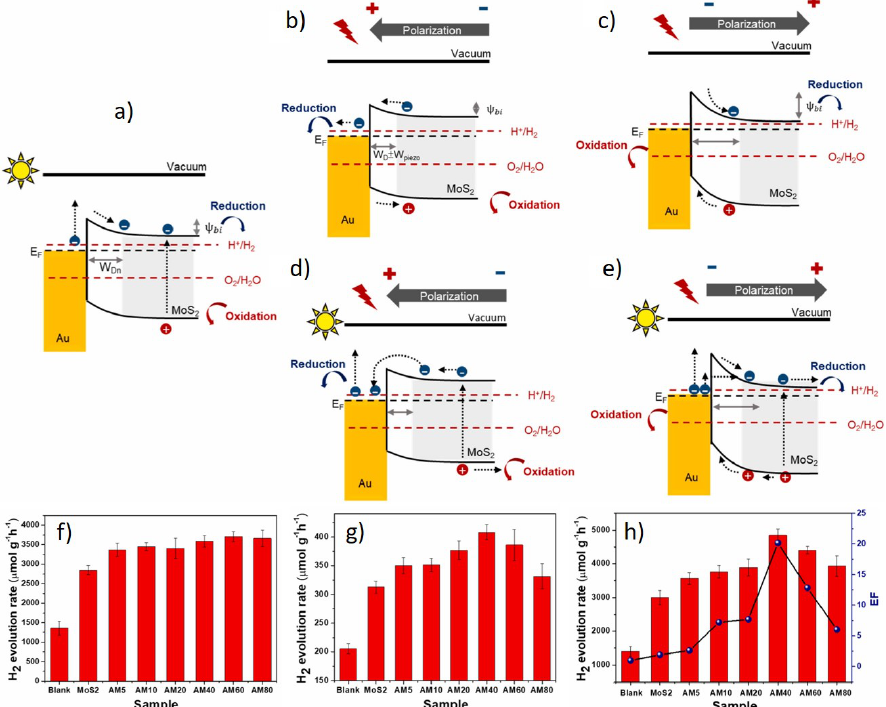
Figure 17. ( a ) The schematic representation of Au@MoS2 photocatalyst during light illumination, considering the contact between Au and MoS 2 with the Fermi level at equilibrium. ( b , c ) Au@MoS 2 photocatalyst under applied mechanical stress, with piezoelectric polarization point to the left side (i.e., under forwarding bias) and piezoelectric polarization point to the right side (i.e., under reverse bias), respectively. The simultaneous light illumination and ultrasonic vibration of Au@MoS 2 NFs with piezoelectric polarization point to the left side ( d ) and piezoelectric polarization point to the right side ( e ). The bottom panel shows the hydrogen evolution rate obtained for Au@MoS 2 NFs photocatalyst with different size Au NPs (i.e., 5, 10, 20, 40, 60 and 80 nm) under light irradiation ( f ), under ultrasonic vibration ( g ) and simultaneous light irradiation and ultrasonic vibration ( h ) [159]. Copyright 2021,